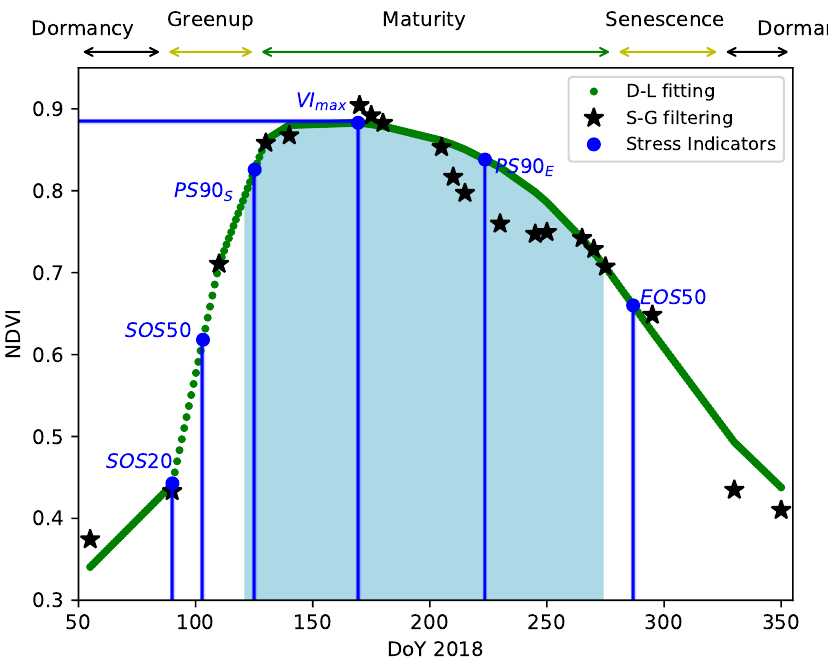
Figure 4. Phenological curve as described by Normalized Difference Vegetation Index (NDVI) (Double logistic approximation in green and Savitzky–Golay filtering in black) and annual phenological characterization criteria (blue), Green period area is colored in light blue for clarity. Case study of Canal de Brienne area, Toulouse, 2018. Main vegetation phenological periods are outlined in the top of the figure: Dormancy, Greenup, Maturity and Senescence